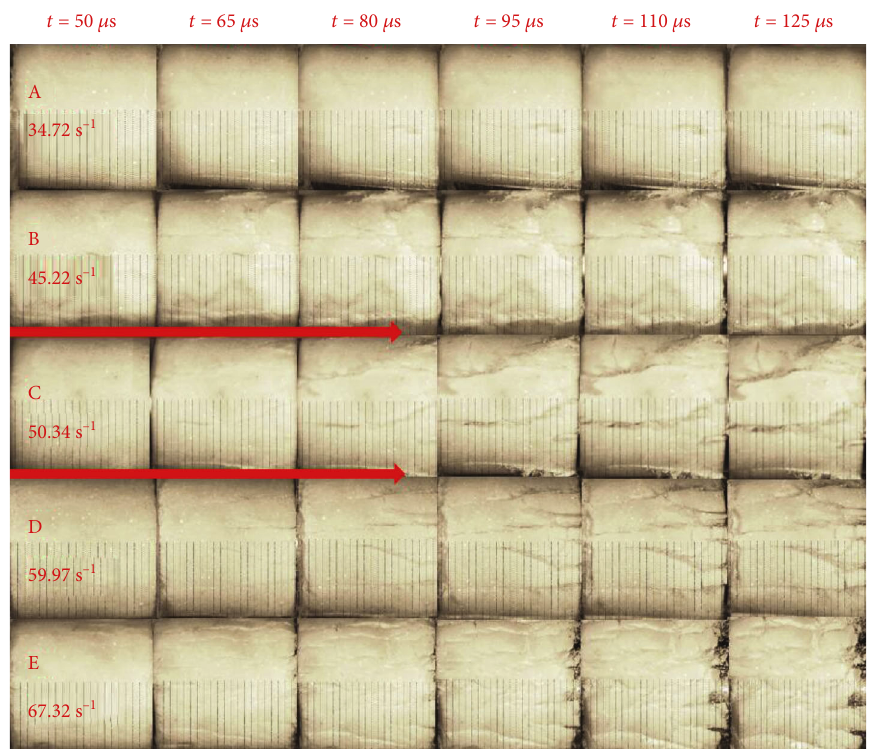
Figure 8: High-speed photography of crack process (impact from left to